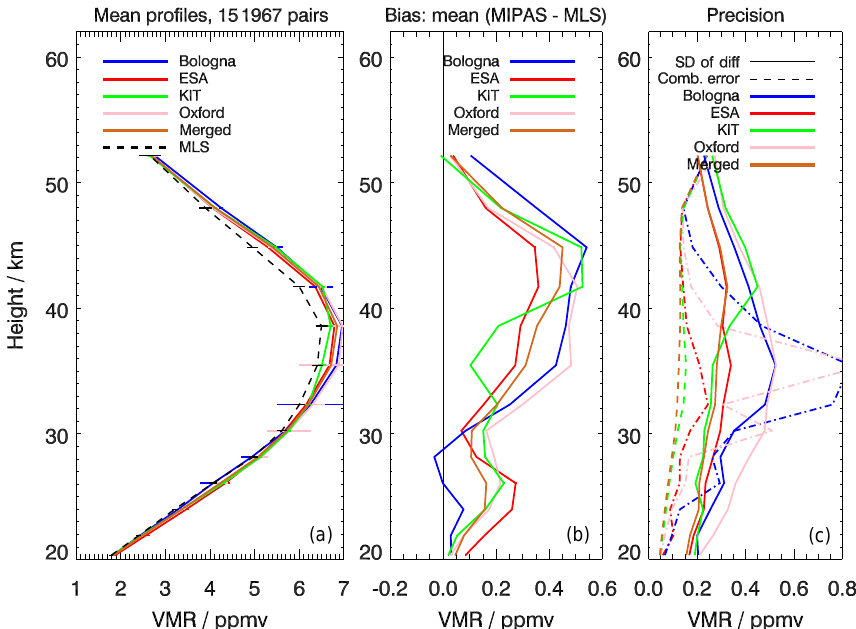
Figure 5. Mean profiles (a) , bias (b) , and precision validation (debiased standard deviation of the differences, c ) of the four parent datasets and merged MIPAS dataset with respect to MLS ozone profiles in